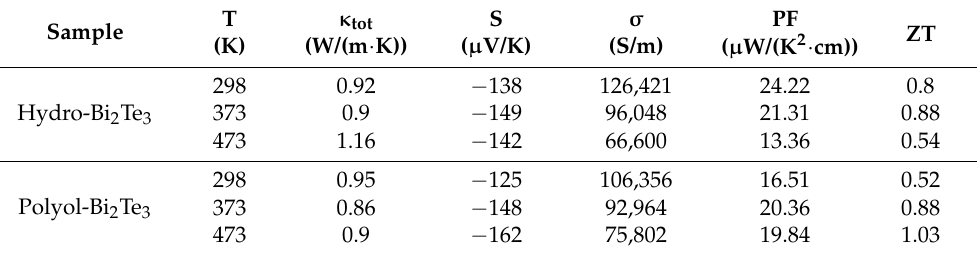
Table 3. A summary of the measured TE transport properties of Bi 2 Te 3 samples synthesized through MW-assisted hydrothermal and polyol routes: total thermal conductivity ( κ tot ), Seebeck coefficient (S), electrical conductivity ( σ ), power factor (PF), and TE figure of merit (ZT) at the given temperature (T)